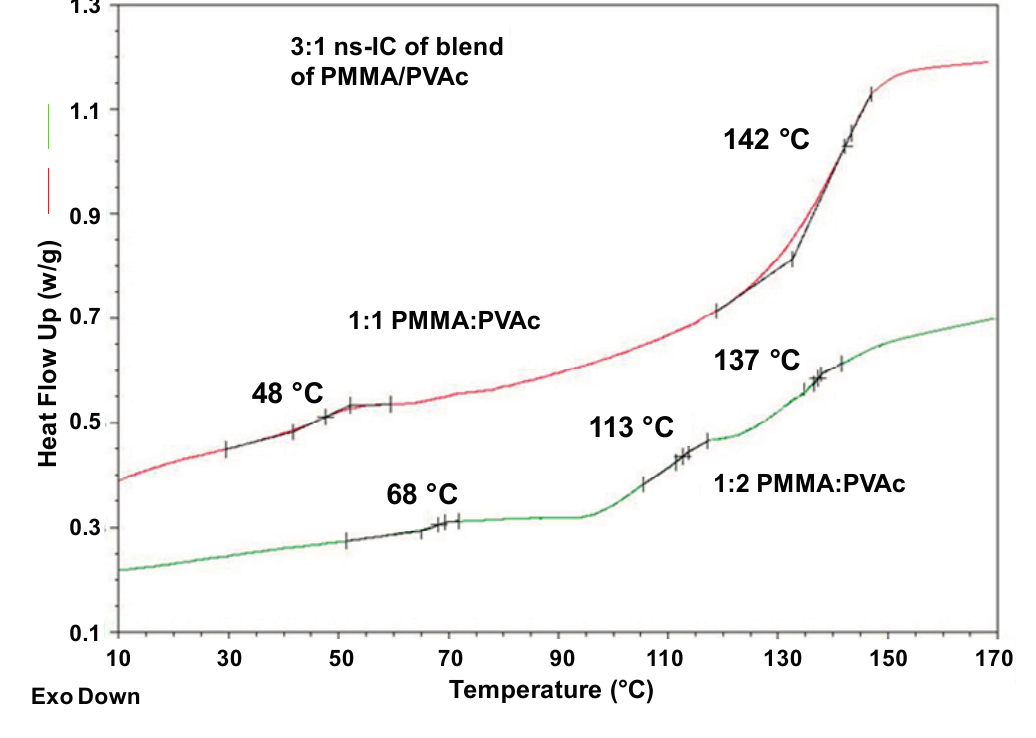
Table 4. T s observed in common (n-s) PMMA/PVAc- γ g